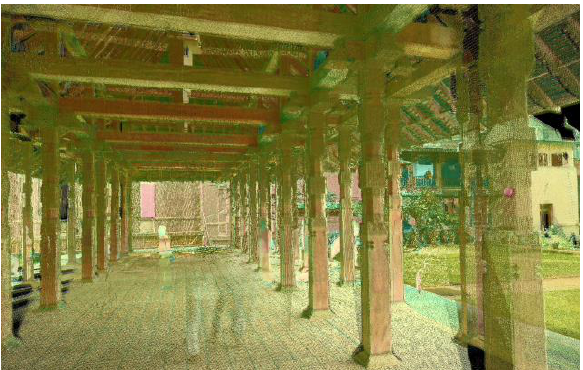
Fig. 4. Point cloud showing the Audience Hall. Combination of reflectance and true colour